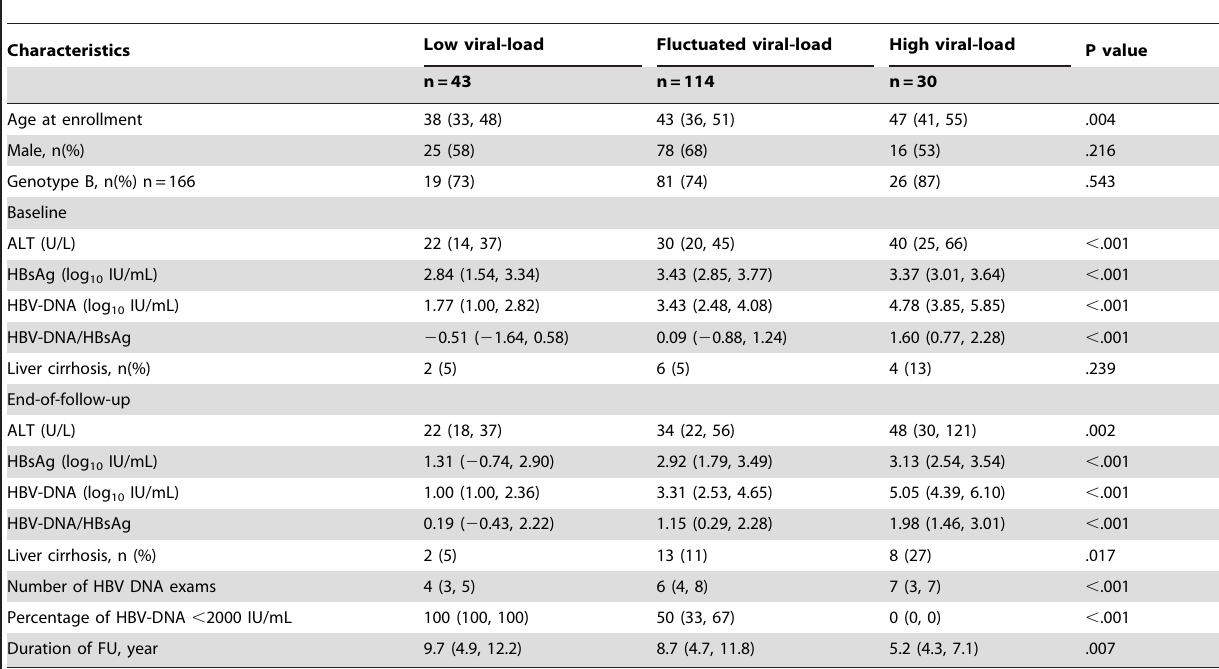
Table 1. Characteristics of HBeAg-negative HBsAg carriers according to their hepatitis